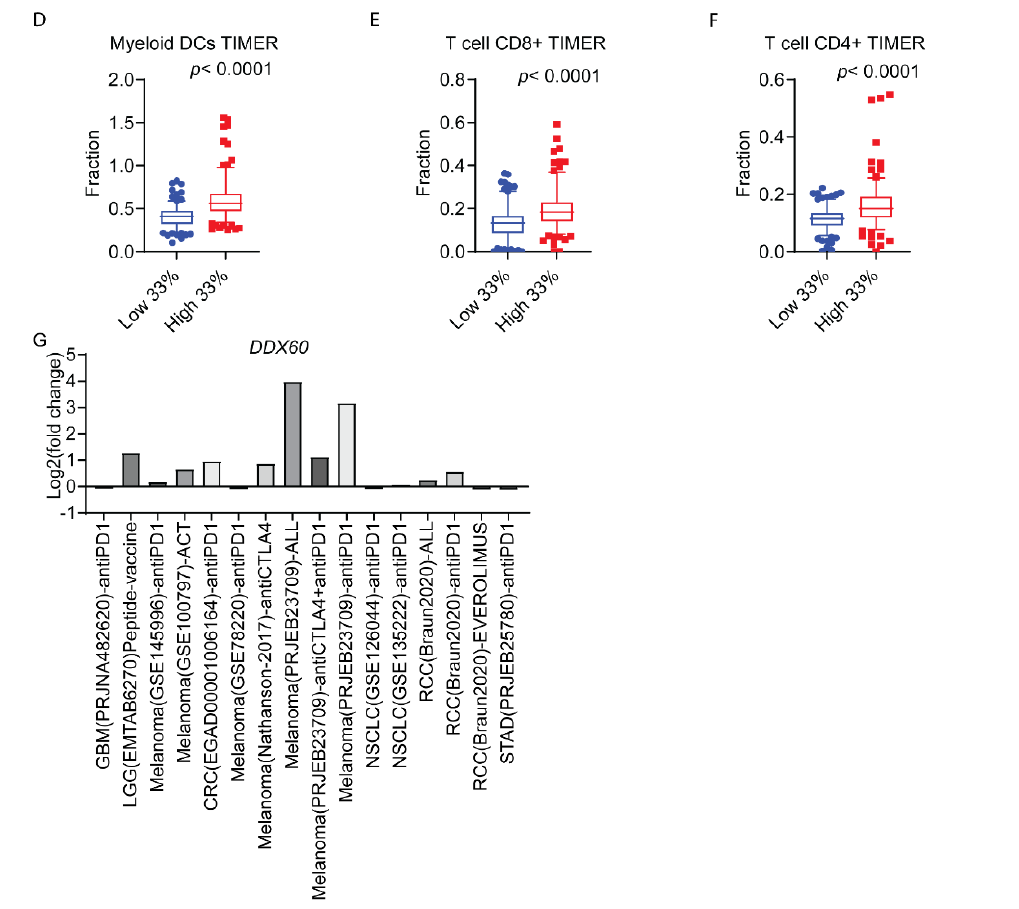
Figure 6. DDX60 expression is correlated with immune cell infiltration and immunotherapy response. ( A – C ) The correlation analysis of DDX60 expression and immune cell infiltration of dendritic cells (DCs), CD8+ T cells, and CD4+ T cells based on TCGA CRC RNA-seq data. ( D – F ) Immune cell infiltration of dendritic cells (DCs), CD8+ T cells, and CD4+ T cells in CRC tissues with high or low DDX60 expression. ( G ) The mRNA expression levels (fold change of Log2) of DDX60 in the tumors from the immunotherapy responders and non-responders in different solid cancer. The gene expression data were obtained from Tumor Immunotherapy Gene Expression Resource (TIGER) at http://tiger.canceromics.org/#/home accessed on 10th may 2022.